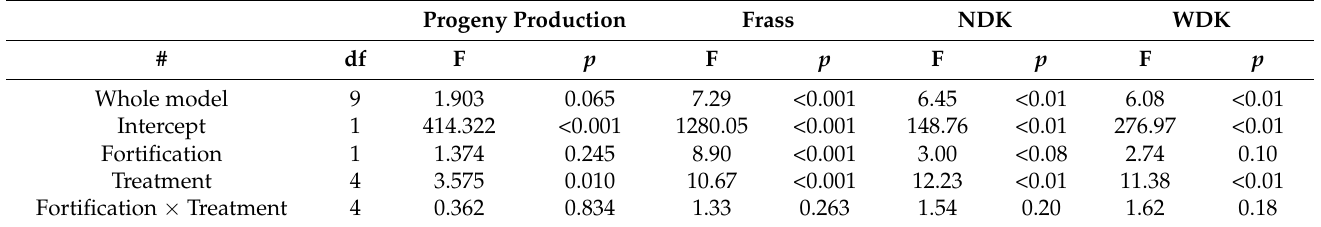
Table 1. ANOVA parameters for population growth of Sitophilus oryzae and quality parameters (frass, number of damaged kernels (NDK) and weight of damaged kernels (WDK)) in vials that contained rice fortified with spearmint or basil at 0, 25, 50, 75 and 100% (total df = 70). Progeny Production Frass NDK WDK